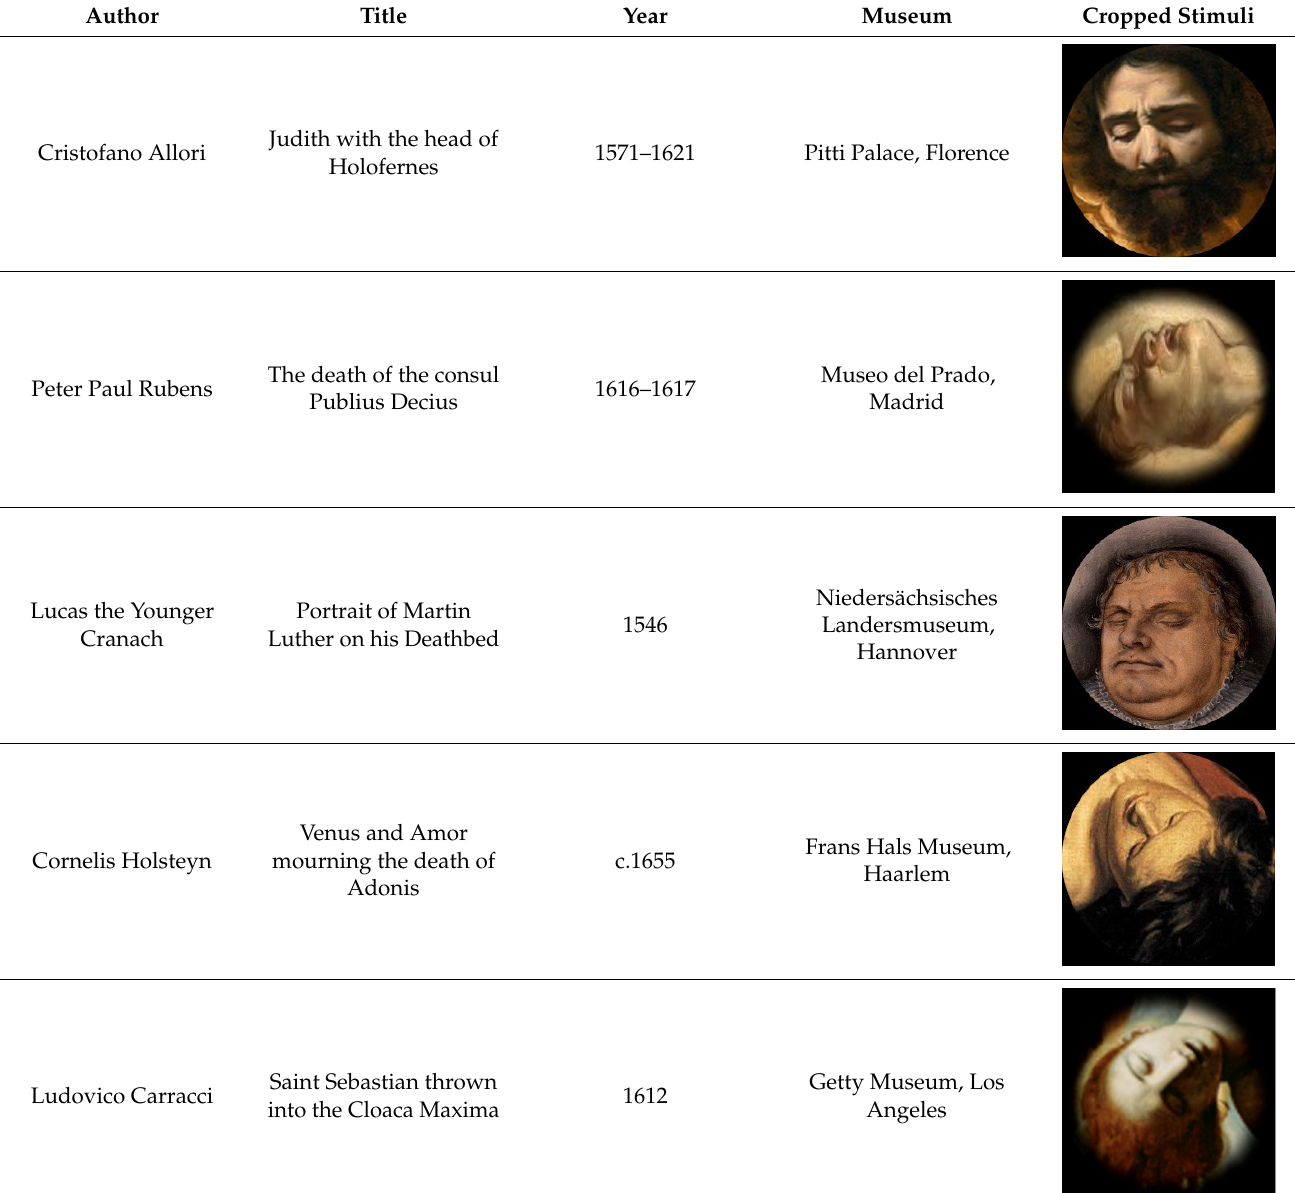
Table 1. Description of the paintings from which the selected stimuli were extracted: author, title, year, museum, cropped stimuli.